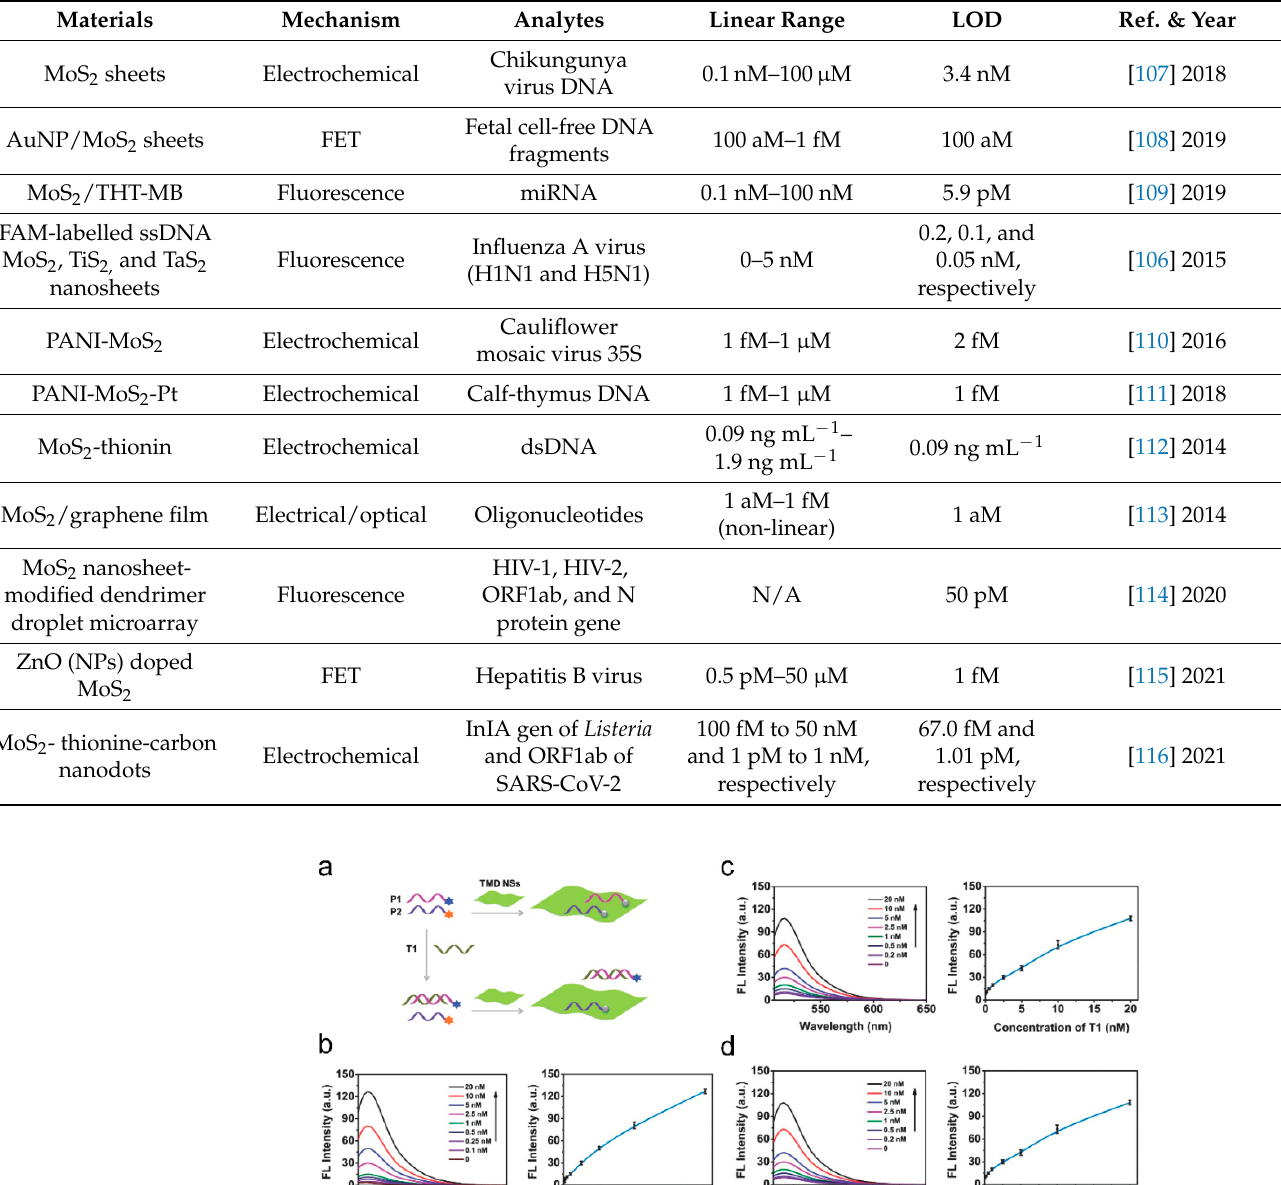
Table 4. Recent 2D TMD-based materials and related mechanisms for probing disease-related nucleic acids and their sensing performances.